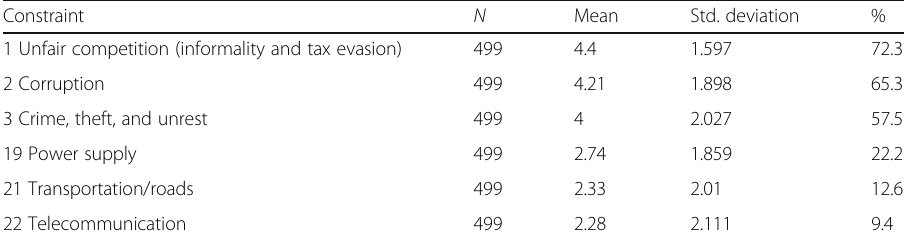
Table 8 Ranking of complementary factors by means and percentage of respondents Constraint N Mean Std. deviation